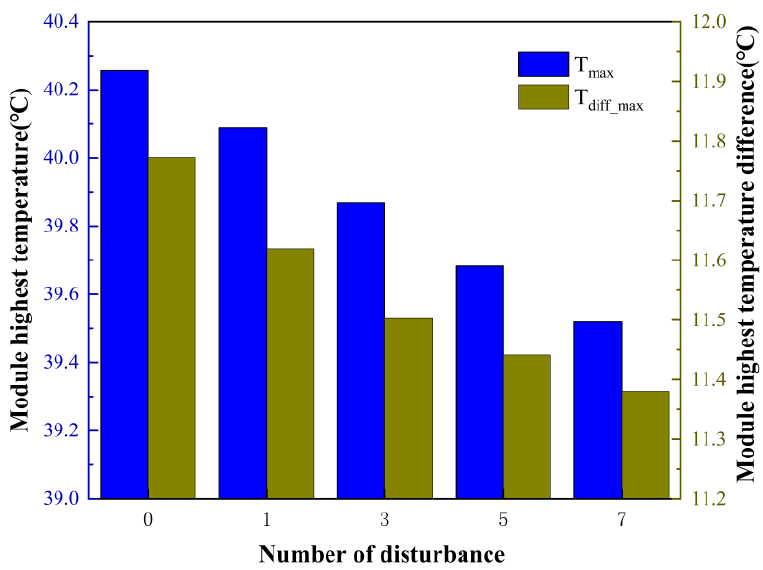
Figure 8. Module temperature under different numbers of disturbance structures.